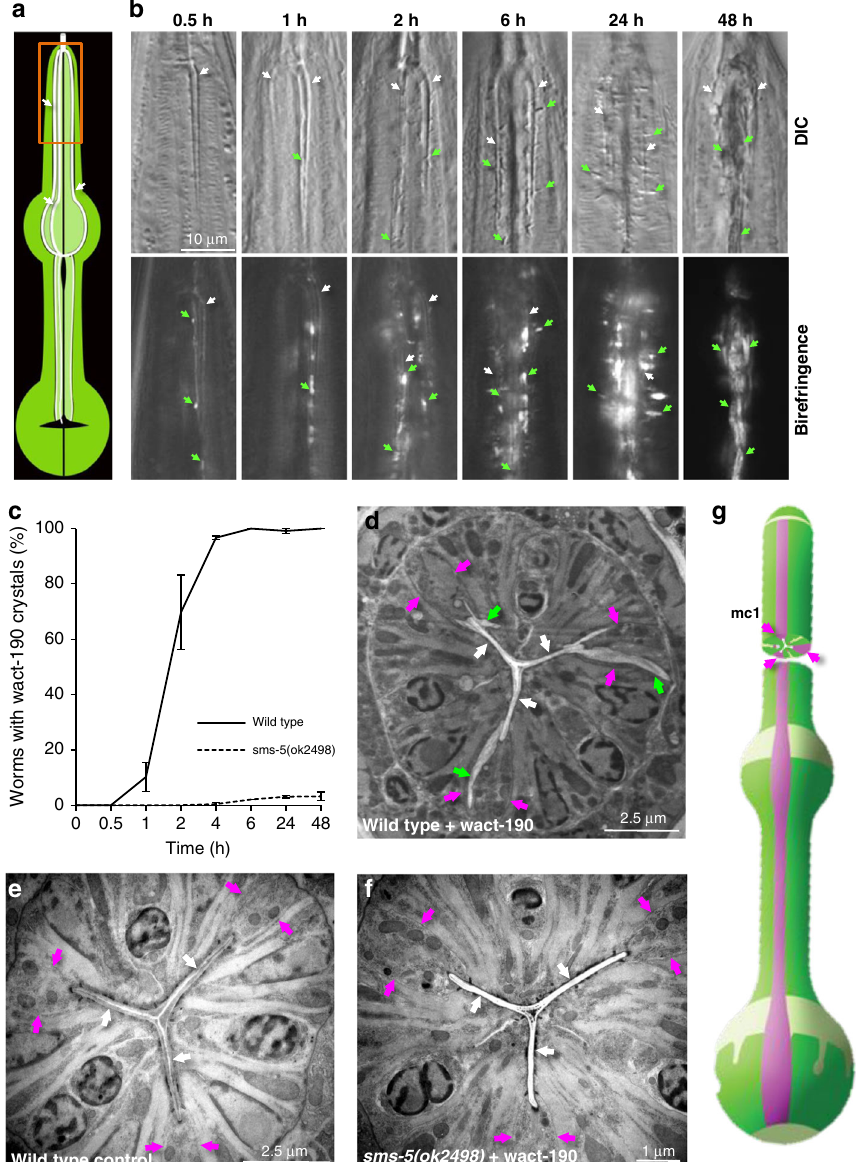
Fig. 3 A microscopic analysis of wact-190 crystal formation. a A schematic of the pharynx with the three channels indicated with white arrows; the central lumen and grinder are in black. The procorpus of the anterior pharynx, which is shown in b , is boxed in orange. b Qualitative analysis of wact-190 crystal formation over time. Synchronized fourth-stage (L4) animals were grown in 60 μ M of wact-190 in liquid culture for the time indicated at the top of each column. The top images show differential interference contrast micrographs; the corresponding bottom images are taken with polarized fi lters to visualize birefringence. Each pair of images shows the procorpus (anterior quarter) of the pharynx. The white arrows indicate channels; green arrows indicate select crystals. The scale is the same for all panels. c Quantitative analysis of wact-190 crystal formation over time. Synchronized fi rst-stage (L1) worms of the indicated genotype were incubated in liquid with 60 μ M wact-190 for the indicated time period and crystals were identi fi ed by their birefringence. Error bars represent standard error of the mean (SEM) and n = 3 independent biological samples. Source data are provided in the Source Data fi le. d – f Transmission electron micrographs (TEMs) of pharynx cross-sections of the indicated genotype and wactive treatment. The channels are indicated with white arrows; presumptive crystals with green arrows; marginal cell plasma membranes with fuchsia arrows. See Supplementary Fig. 5 for transverse sections. g A schematic of the pharynx illustrating the approximate area of the cross-sections imaged by TEM. The marginal cells are indicated in fuchsia. Image adapted from WormAtlas with